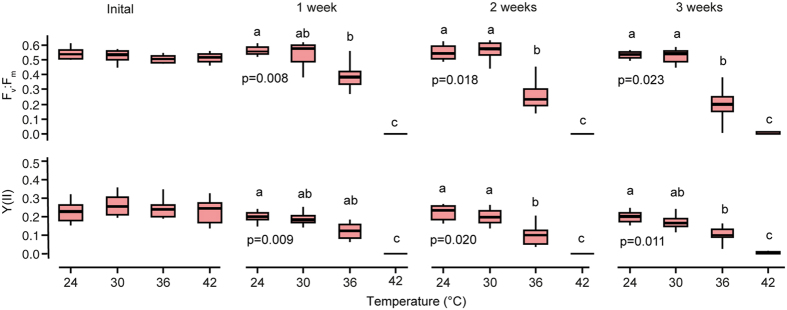
Photochemistry responses in the extreme exposure experiment (SPEE) of Pararotalia calcariformata over three weeks to elevated temperatures.Fv:Fm maximum quantum yield, Y(II) effective quantum yield measured at experimental light intensity, data plotted are shown as boxplots (the top and bottom of the box represent 1st and 3rd quartile, the 2nd quartile the median, and the lines extending from the box extent to the outermost data that fall within the distance computed as 3rd quartile ± 1.5 *interquartile range), Each graph has N = 47–48 independent data points, which are given as means per well, each well contained N = 5–6 measurements, see Table S1 for statistical analysis.